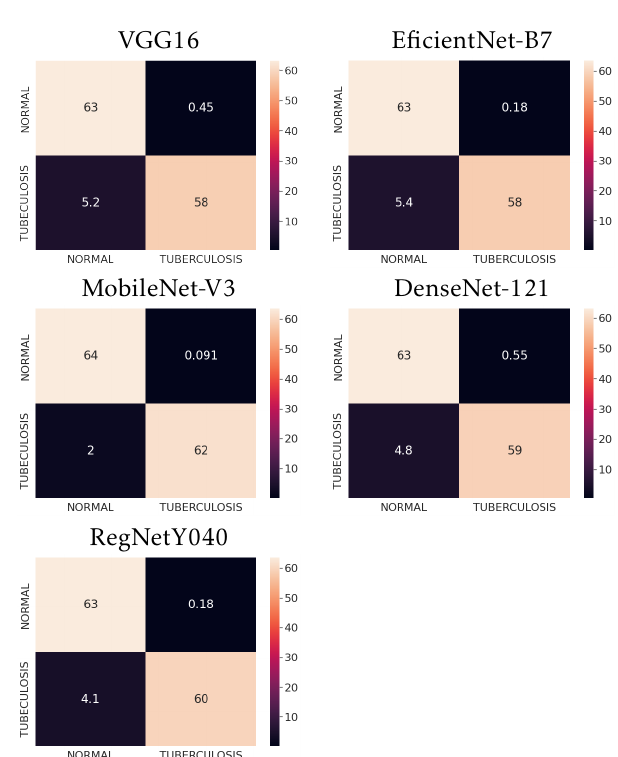
Figure 10. Confusion matrices for models applying to Tuberculosis (TB) Chest X-ray database - MobileNet-V3 shows better results with True Positive and False Negative images detected are quite high - 64 and 62 correspondingly